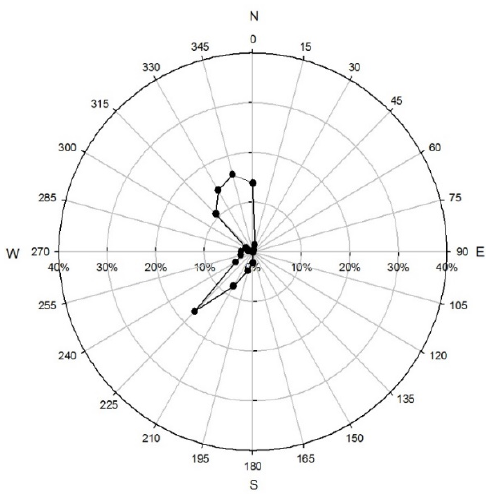
Figure 2. Probability distribution for the incidence of wind for the Qigu buoy (2013–2017).